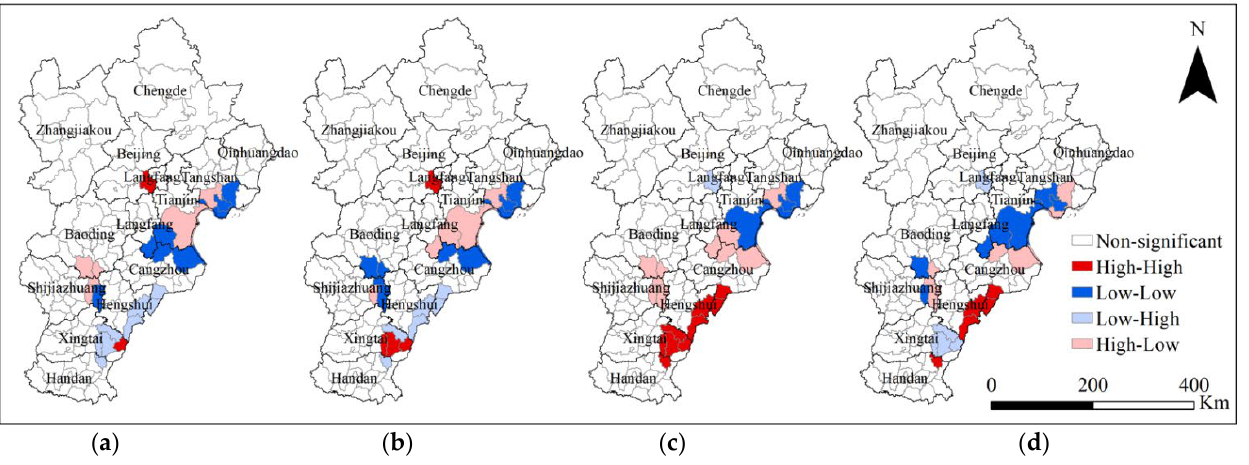
Figure 5. Spatial autocorrelation of urban–rural resilience and ( a ) construction land proportion, ( b ) construction land proportion change, ( c ) cultivated land proportion, and ( d ) cultivated land proportion change in the BTHUA.